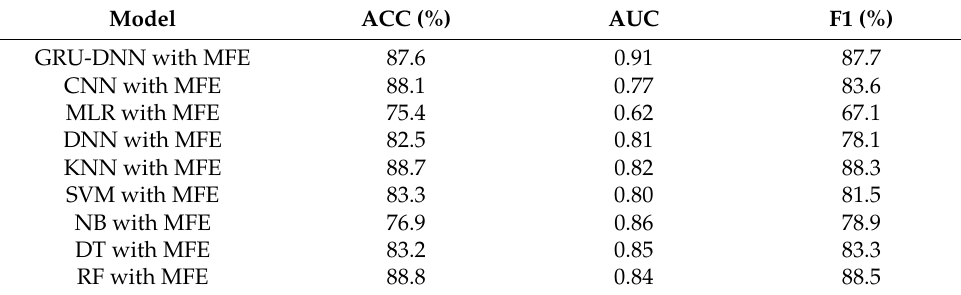
Table 7. Comparisons among nine